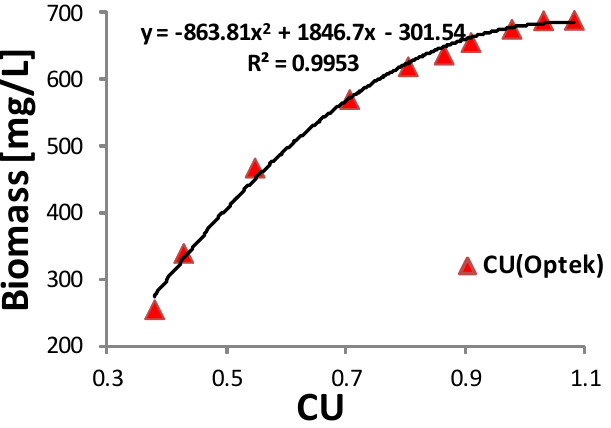
y = -863.81x 2 + 1846.7x - 301.54 R² = 0.9953